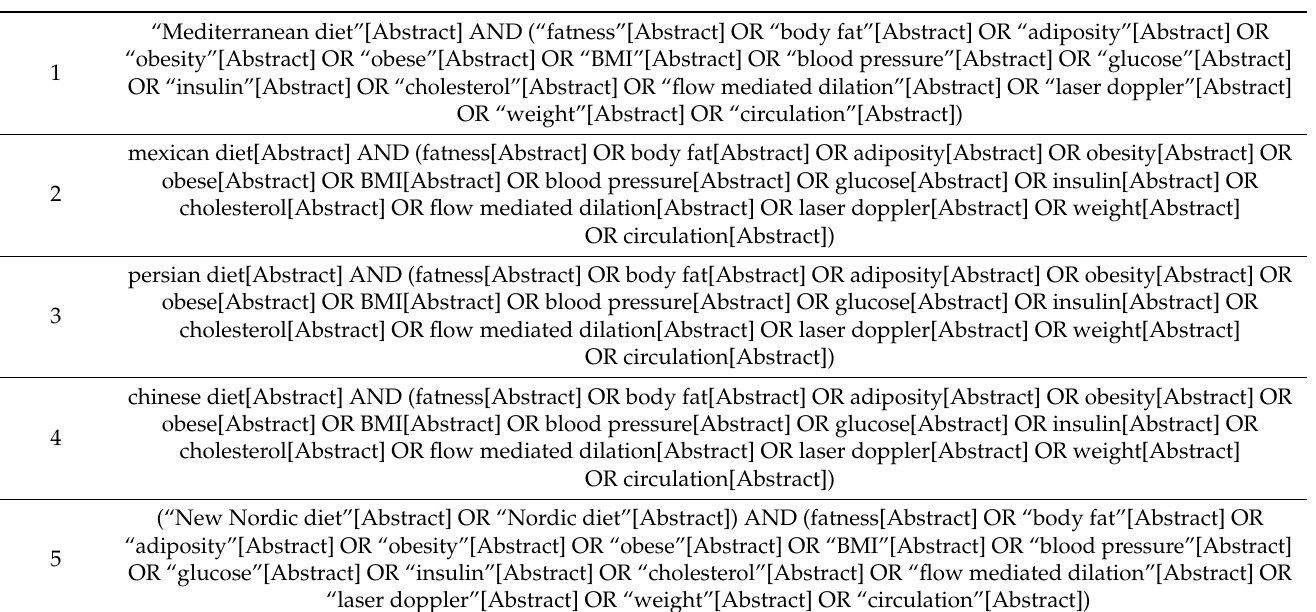
Table 2. Detailed search strings used for the PubMed